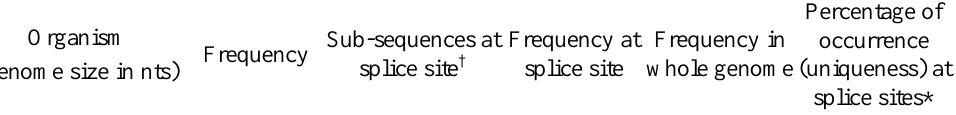
Table 4b. Frequency of occurrence of different sub-sequences (size ten) at the acceptor splice site region and the whole genome of the respective